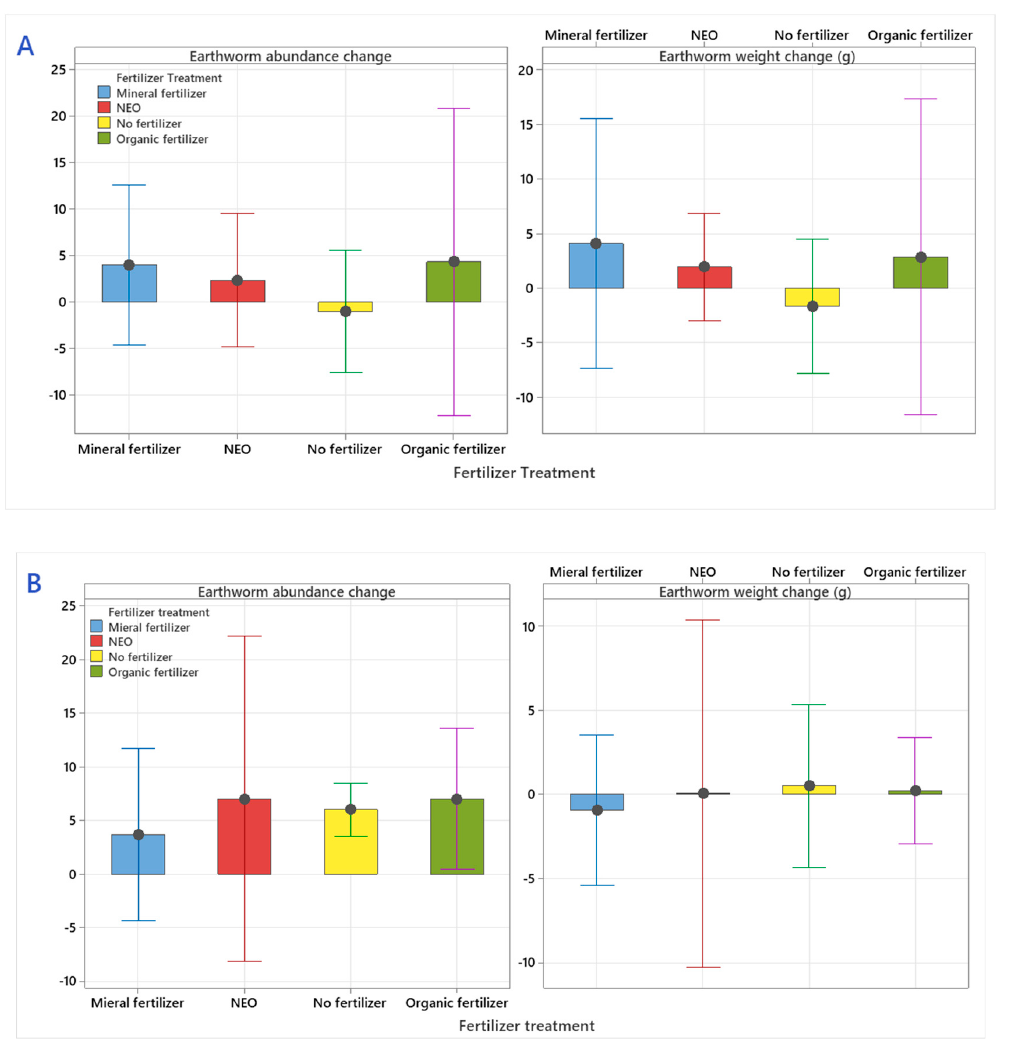
Figure 4. The immediate effect of different fertilization treatments on the abundance (left) and weight (right) of earthworms in ( A ) June 2021 and ( B ) June 2022. Error bars are individual standard deviations at a 95% confidence interval.